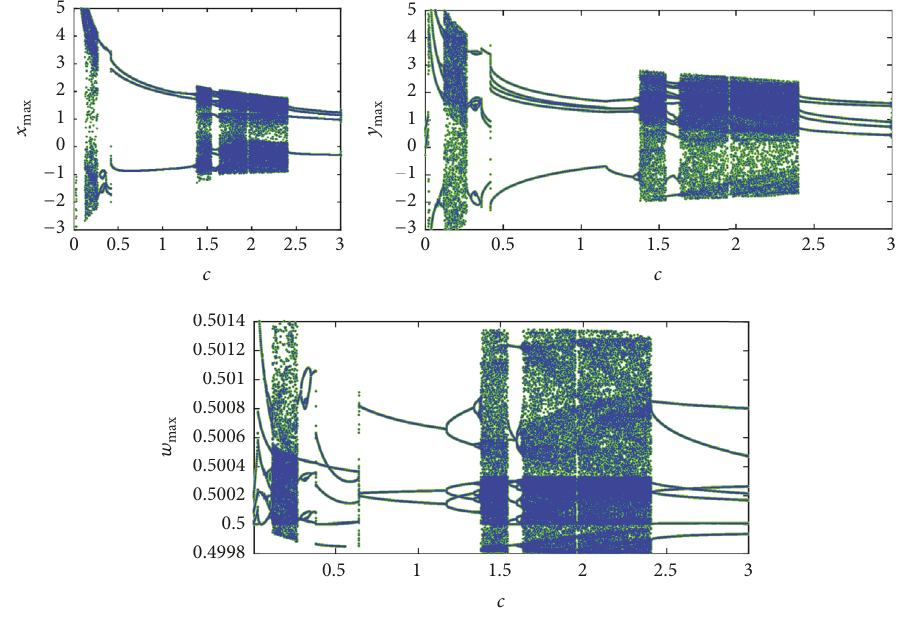
Figure 6: Bifurcation of FOPF system for 𝑐 .